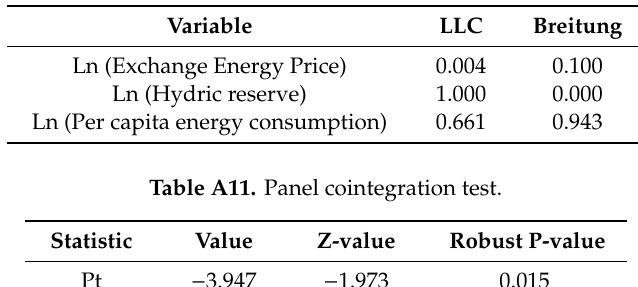
Table A10. Panel unit root test.